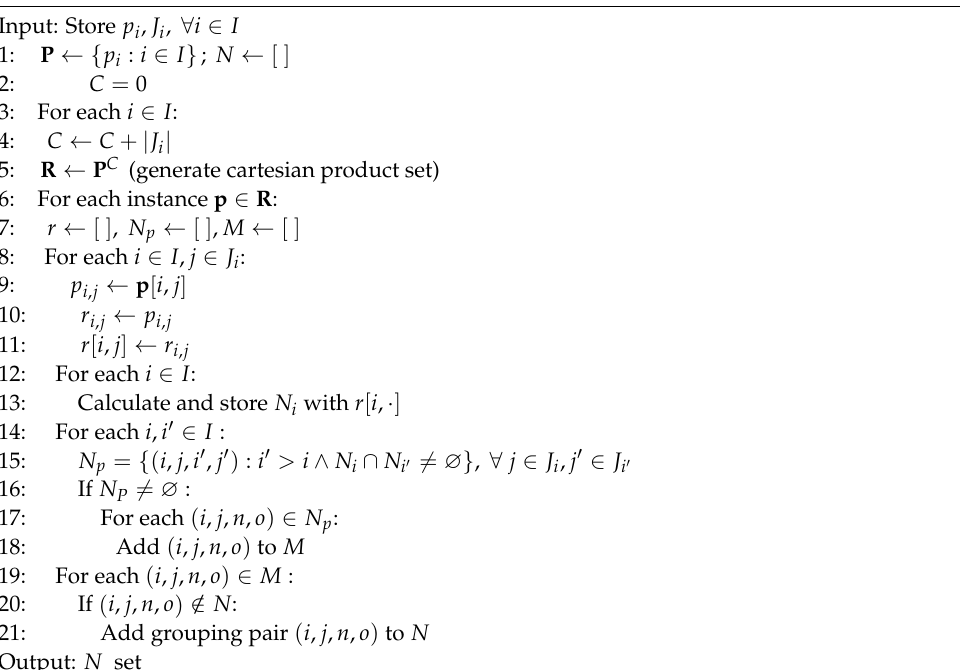
Algorithm 1: Generation of feasible PM grouping